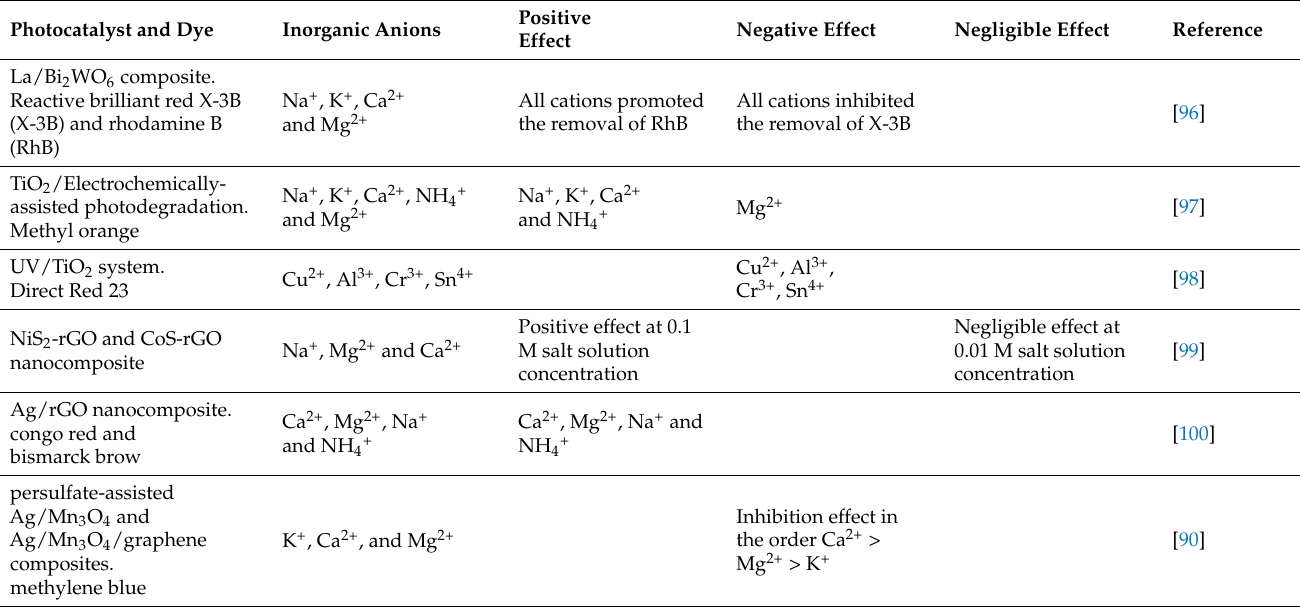
Table 3. Effect of inorganic cations present in TW on photodegradation of